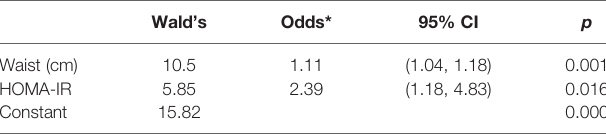
TABLE 7 | Predictive factors for increasing odds of hepatic steatosis in subjects with no MetS components. Wald ’